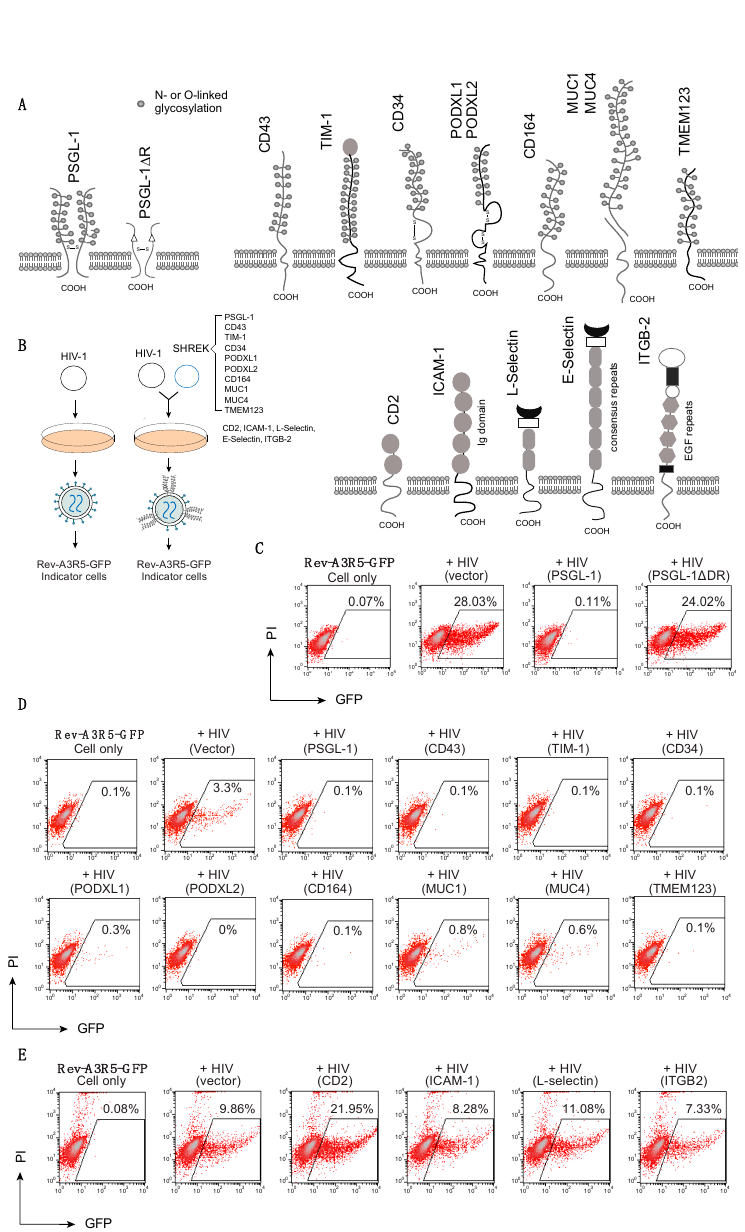
Figure 1. ( A ) Schematic of PSGL-1 and PSGL-1 ∆ DR mutant, SHREK proteins, and other surface receptors used in this study. ( B ) Schematic of virion production in the presence of SHREK proteins in virus producer cells. ( C ) Requirement of the DR domain of PSGL-1 for blocking HIV-1 infectivity. HEK293T cells were cotransfected with HIV(NL4-3) DNA (1 µ g) plus the vector expressing PSGL-1 or PSGL-1 ∆ DR (400 ng). Virions were harvested at 48 h post-transfection and normalized for p24. Viral infectivity was quantified by infecting Rev-A3R5-GFP indicator cells with 300 ng p24 input of the viruses. HIV-1 replication was quantified by GFP expression at 72 h post infection. This experiment was repeated 3 times. ( D ) SHREK proteins inactivate HIV-1 virion infectivity. HEK293T cells were cotransfected with HIV(NL4-3) DNA (1 µ g) plus each individual SHREK-expressing vector (100 ng for TIM-1, 500 ng for other SHREKs). Virions were harvested at 48 h and normalized for p24, and viral infectivity was quantified by infecting Rev-A3R5-GFP indicator cells with 35 ng p24 input of each virus. Shown are the percentages of GFP+ cells at 72 h post infection. The experiment was repeated 3 times. ( E ) For comparison, cells were also similarly cotransfected with HIV-1(NL4-3) DNA plus an empty vector or the vector expressing CD2, ICAM-1, L-selectin, or ITGB2. Virions were harvested and quantified by infecting Rev-A3R5-GFP indicator cells with 50 ng p24 input of each virus. The experiment was repeated 3